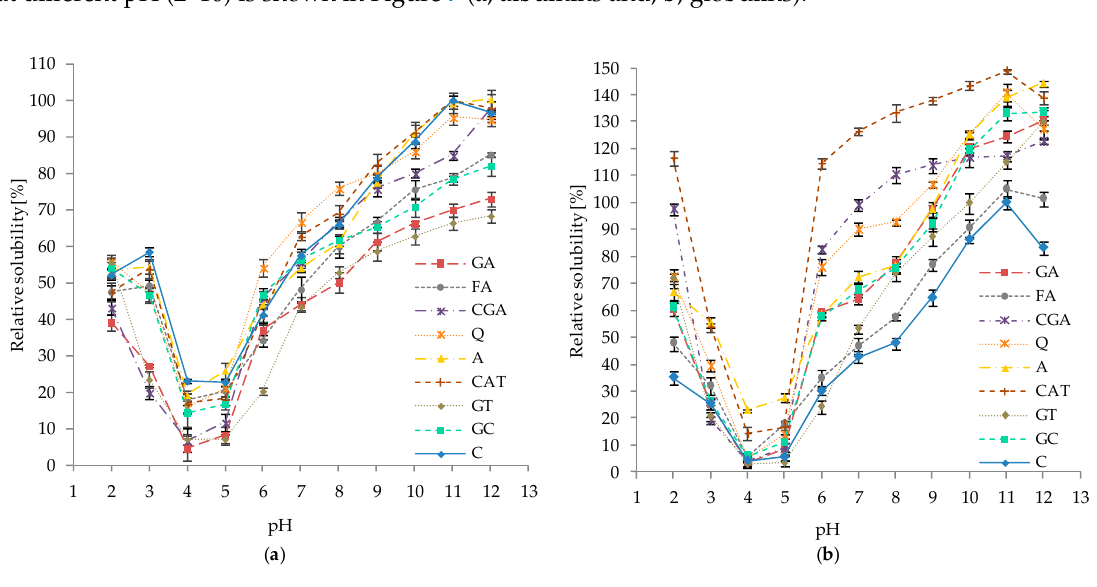
Figure 7. Relative solubility of white bean proteins affected by phenolic compounds at different pH values: ( a ) albumins; and ( b ) globulins. Points represent means ( n = 3) ± SD. C–control sample, GA, FA, CGA, Q, A, CAT, GT, GC–protein samples after incubation with gallic acid, ferulic acid, chlorogenic acid, quercetin, apigenin, catechin, green tea, and green coffee extracts, respectively.